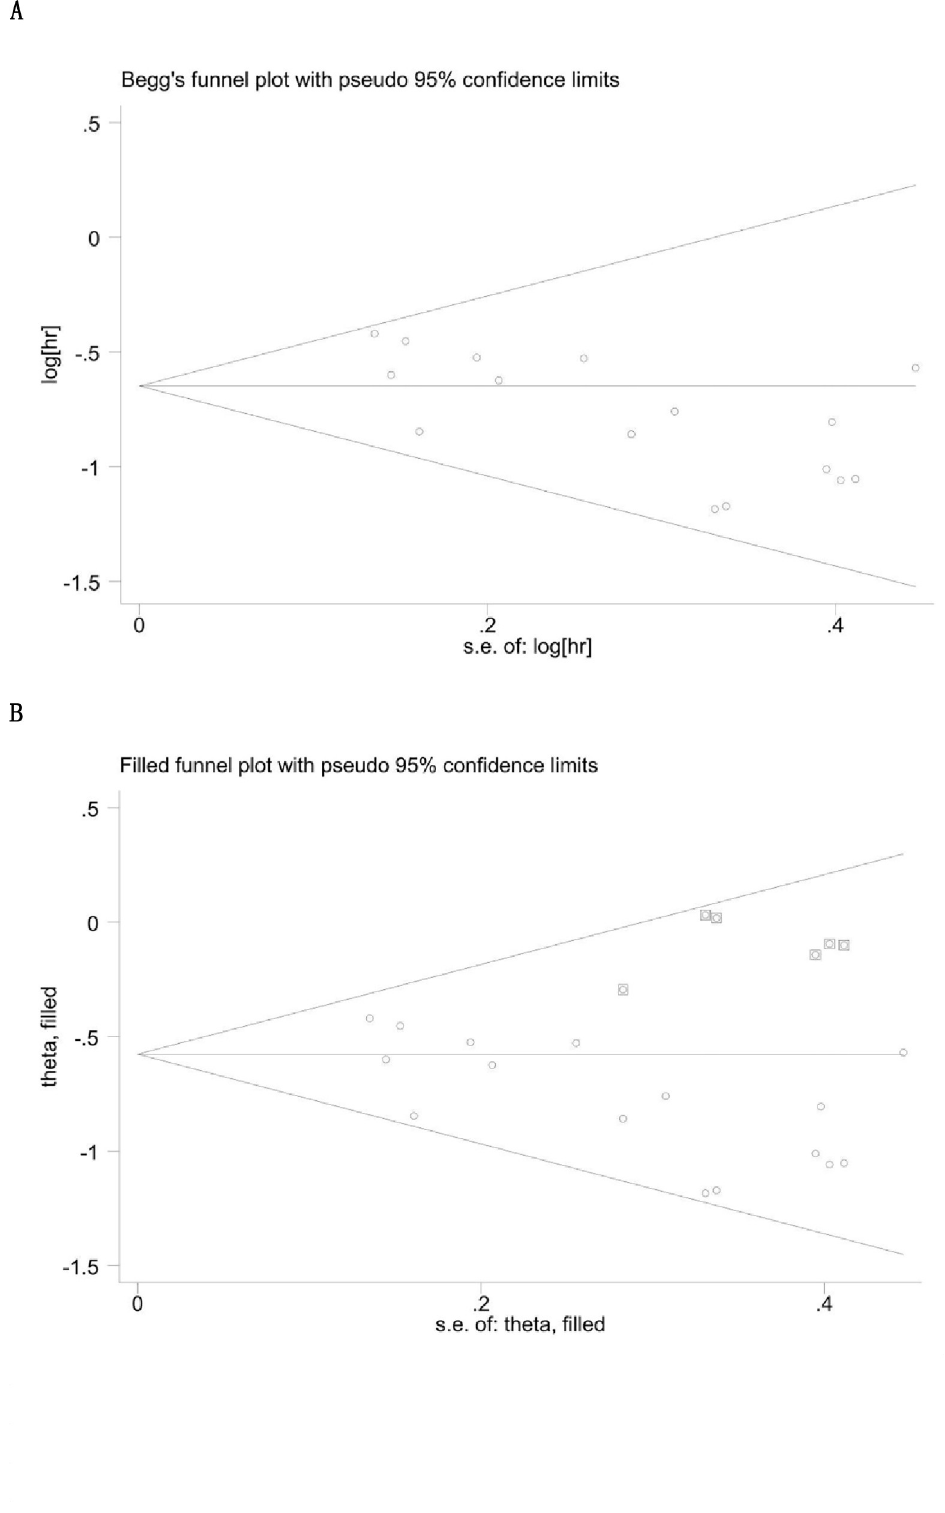
Fig 4. Funnel plots for the evaluation of potential publication bias. A. Funnel plots depicting the publication bias among the included studies on overall survival. B. The adjusted funnel plots depicting the publication bias among the included studies on overall